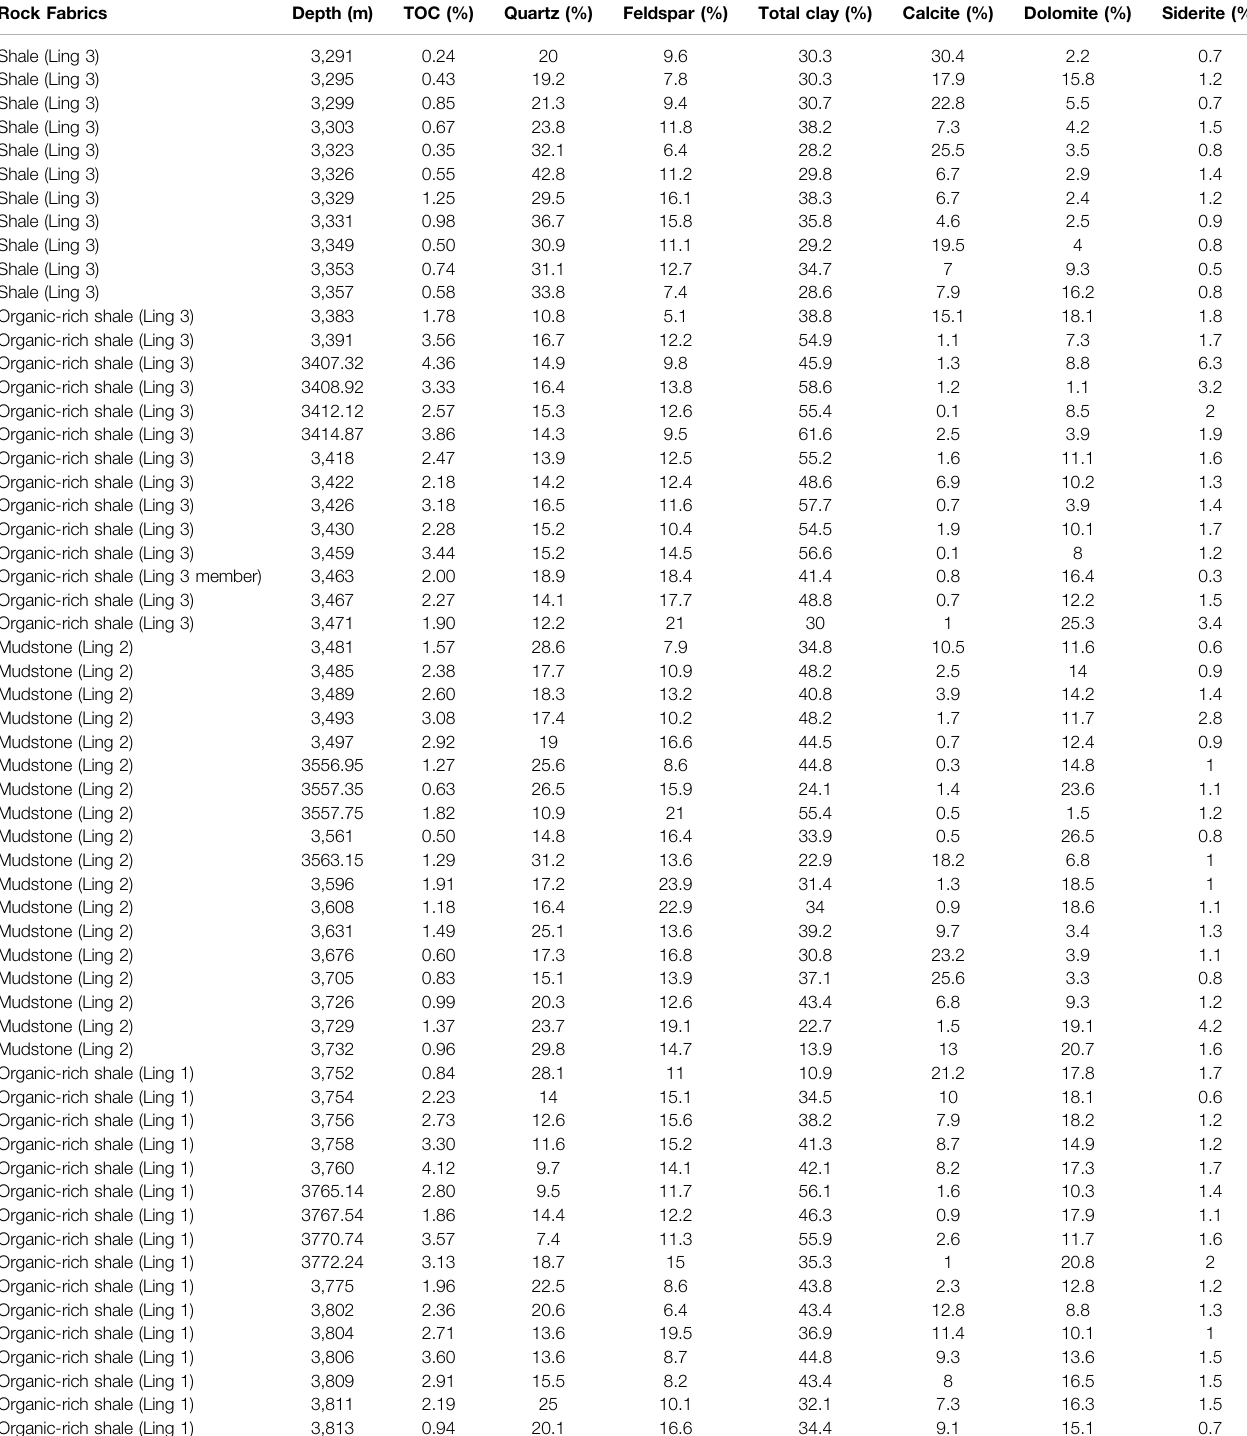
TABLE 2 | TOC content and mineralogical composition of the Upper Permian Linghao Formation shale/mudstone from studied well. Rock Fabrics Depth (m) TOC (%) Quartz (%) Feldspar (%) Total clay (%) Calcite (%) Dolomite (%) Siderite (%) Shale (Ling